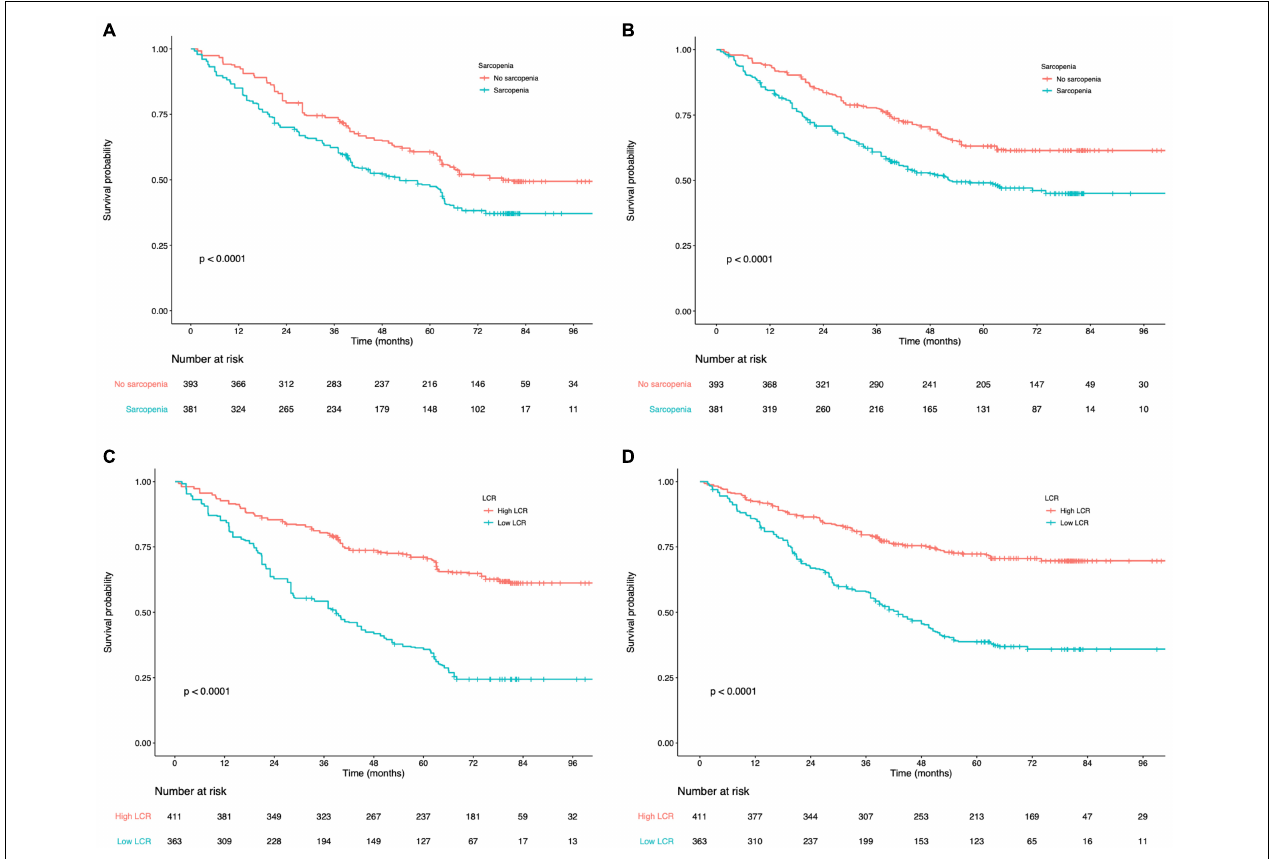
FIGURE 2 | (A) Kaplan–Meier curves for overall survival according to the preoperative sarcopenia status. (B) Kaplan–Meier curves for disease-free survival according to the preoperative sarcopenia status. (C) Kaplan–Meier curves for overall survival according to the preoperative LCR. (D) Kaplan–Meier curves for disease-free survival according to the preoperative LCR. LCR, lymphocyte-to-C-reactive protein